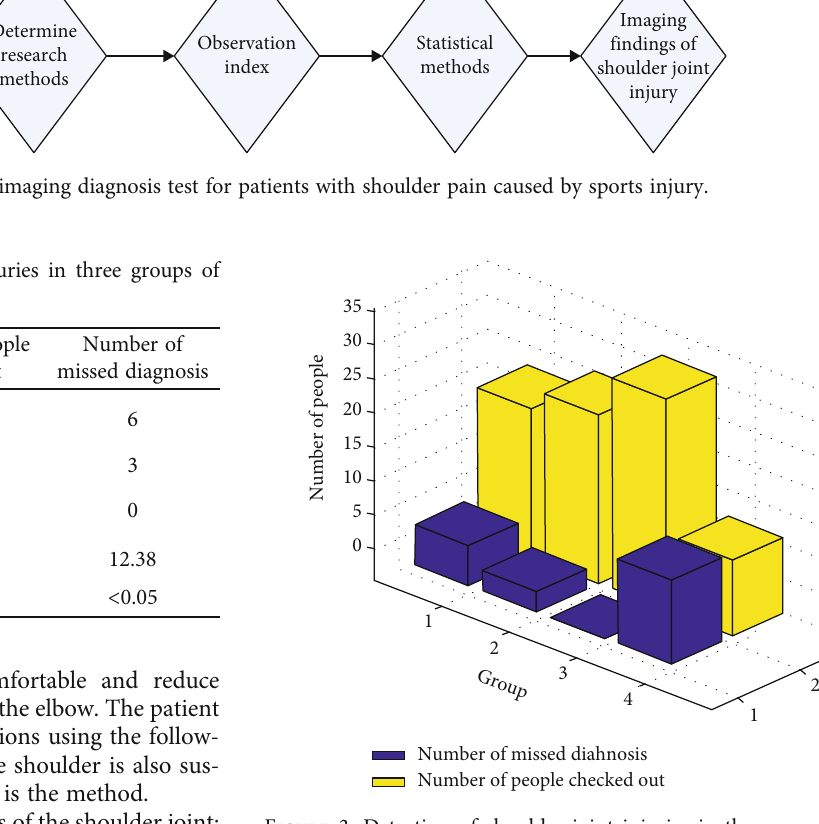
Figure 3: Detection of shoulder joint injuries in three groups of patients. Table 2: The proportion of shoulder joint injuries detected in the three groups.